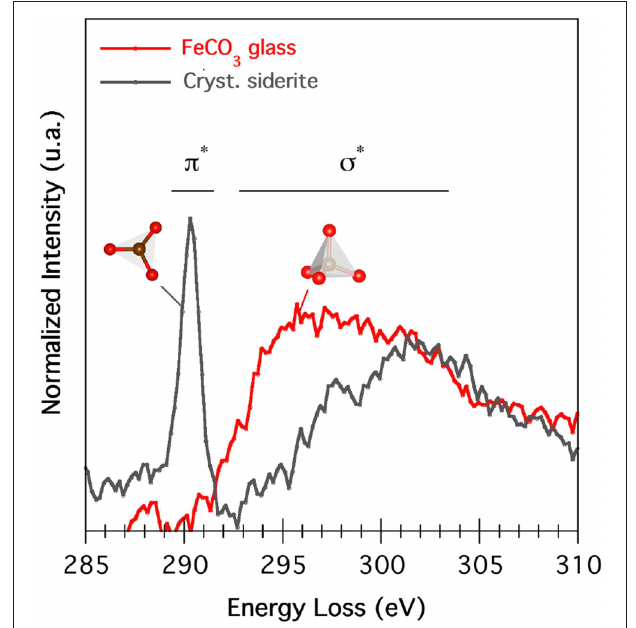
FIGURE 5 | X-ray Raman spectra collected at the carbon K-edge on crystalline siderite and high P -quenched FeCO 3 glasses at ambient conditions. The disappearance of the π ∗ feature, which is solely related to the three-fold coordinated carbon, is a spectroscopic evidence of a full four-fold coordination state in the glassy structure of FeCO 3 .